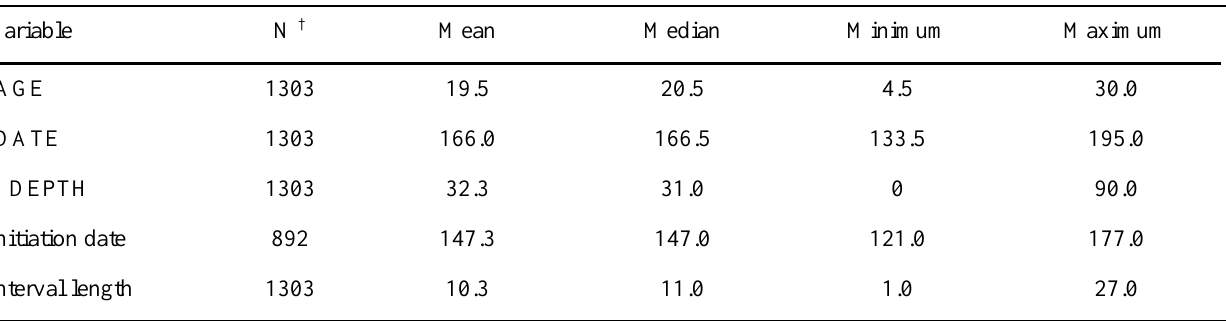
Table 2. Summary statistics of explanatory variables and other selected variables for American Coot ( Fulica Americana ) nests at Grays Lake, Idaho, 1997–2000. Dates given are Julian dates. Variable N †